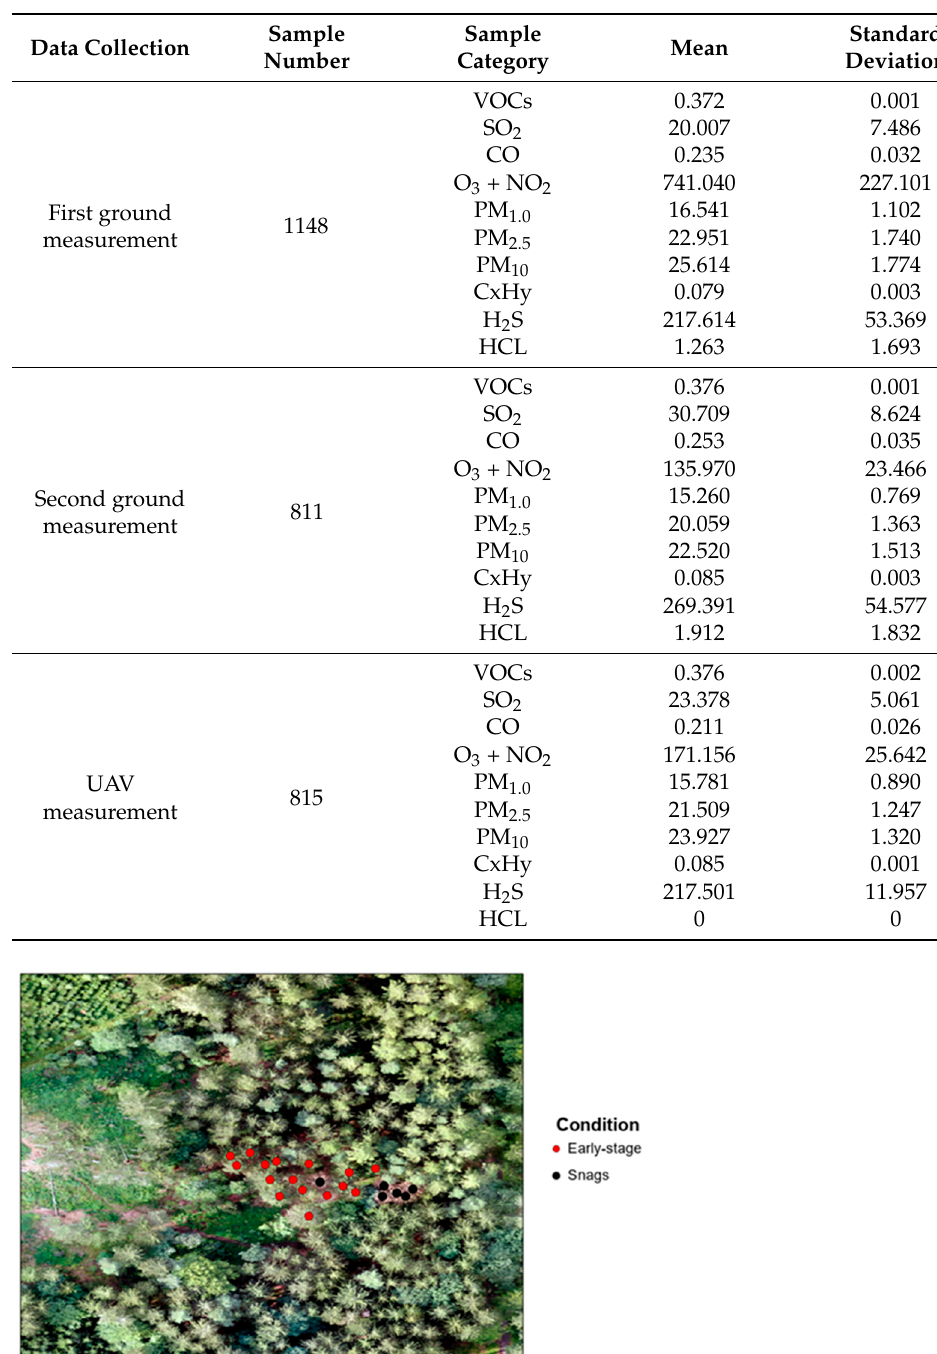
Table 1. Description of collected data, first ground collection, second ground collection, and UAV data collection.